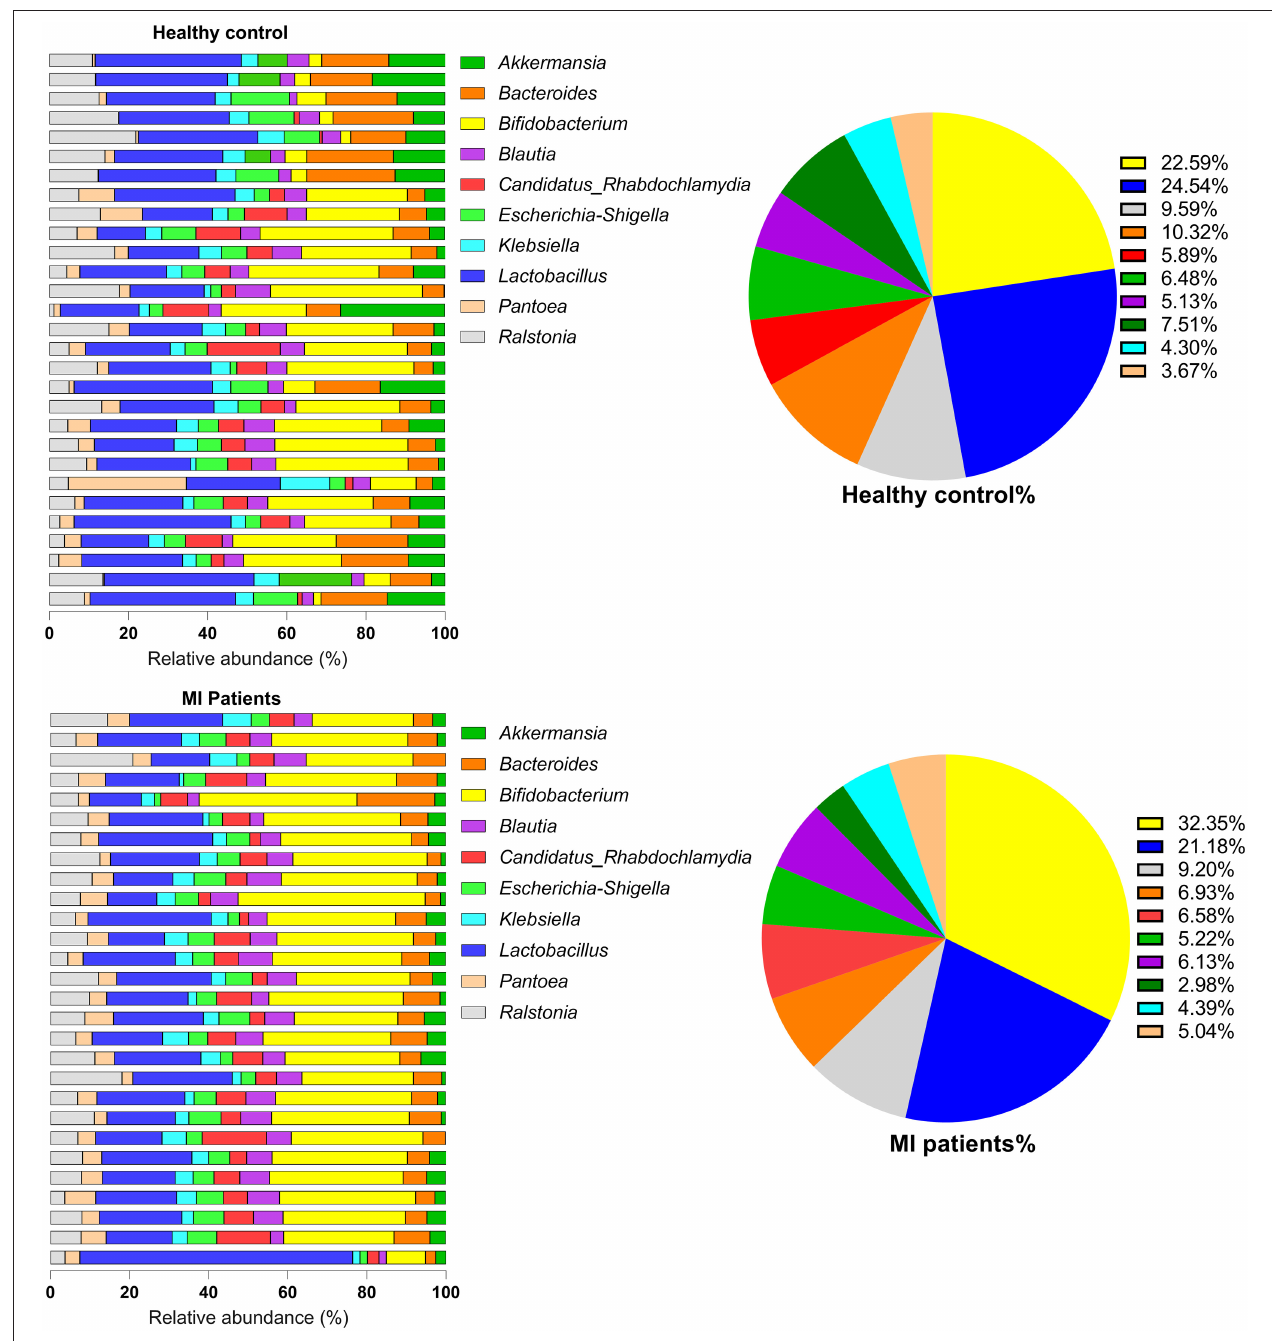
FIGURE 3 | The genus-level abundance of HC and MI groups. Pie charts indicate the percentages of each of the top 10 high-abundance genera in both groups.